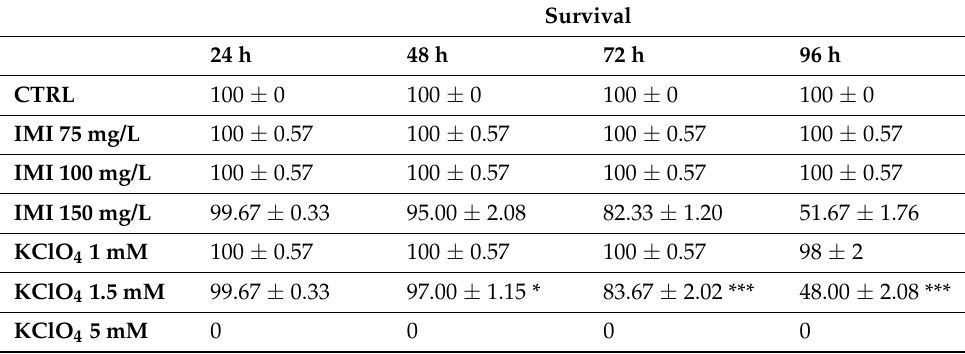
Table 2. IMI and KClO 4 effects on survival rate.